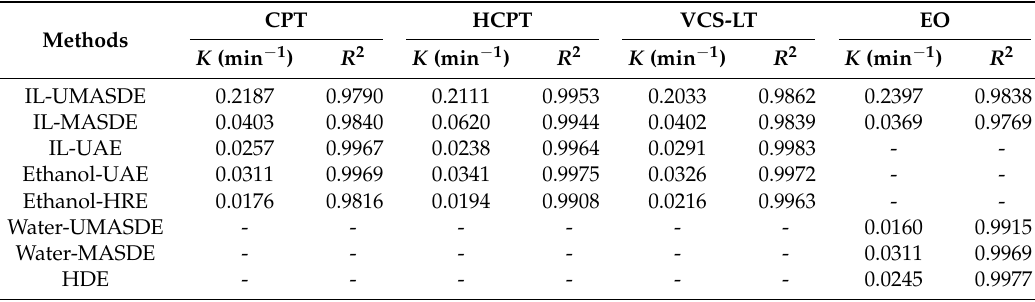
Table 4. The reaction rate constants ( K ) and correlation coefficients ( R 2 ) of first order equations for different extraction